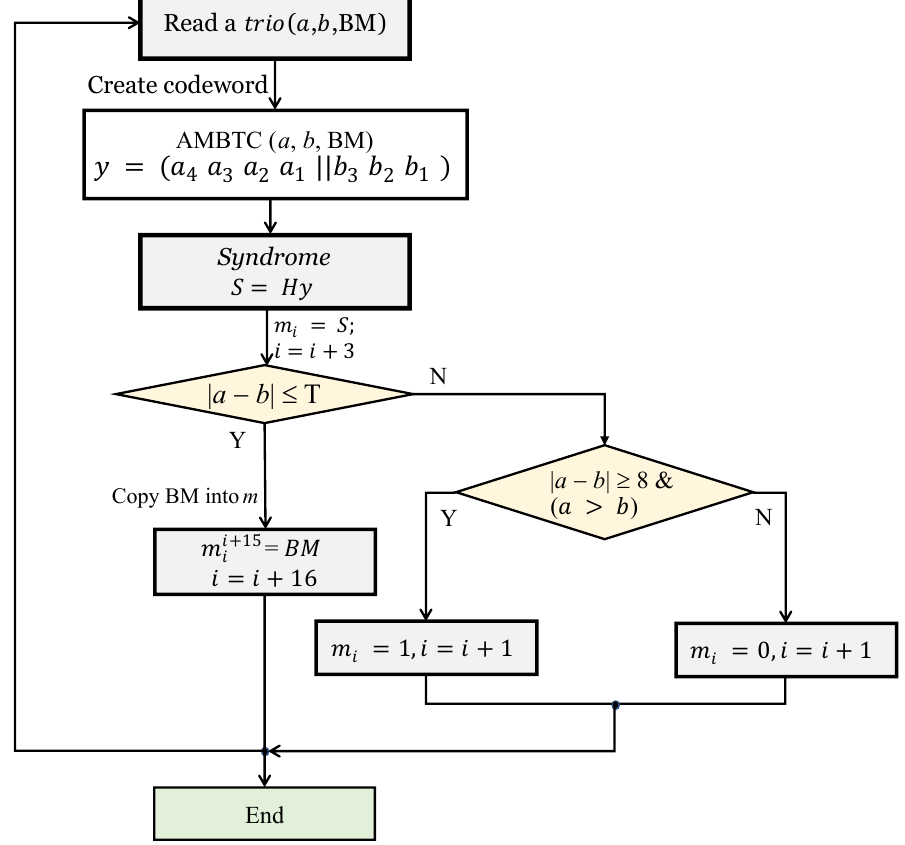
Figure 5. The flowchart of the extracting